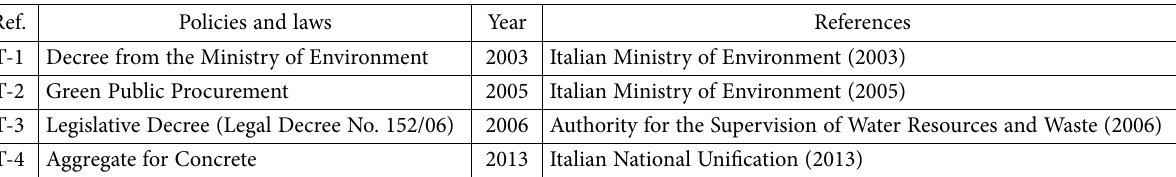
Table 7. Existing policies and laws on C&D waste management in Italy Ref.